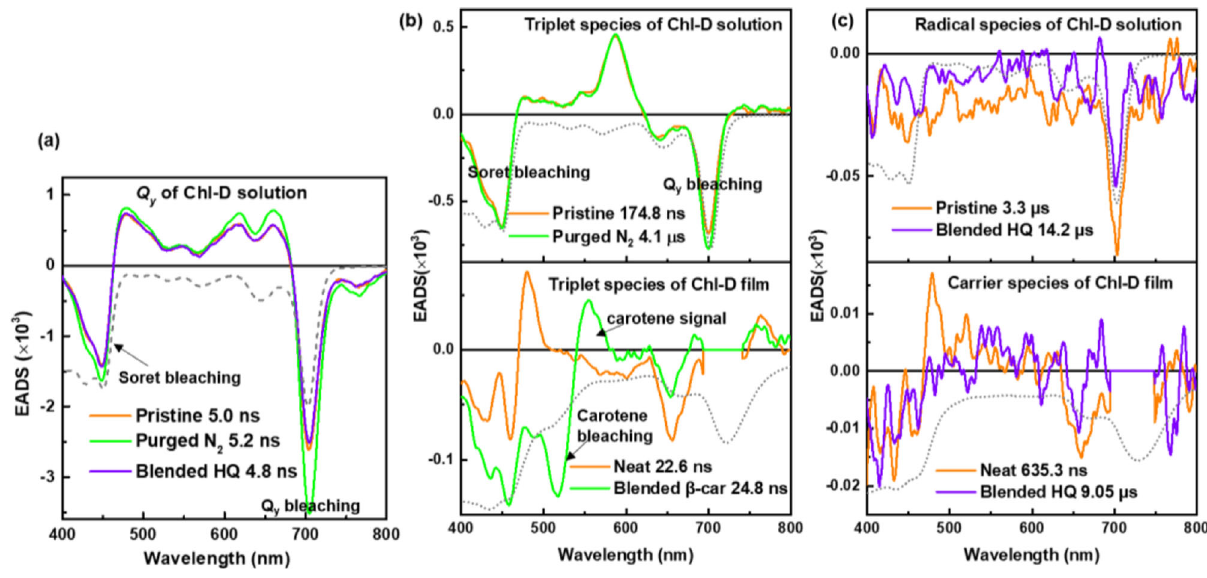
Fig. 5 The different species of EADS comparison of the Chl-D solution and fi lm. a EADS of singlet species comparison of the pristine Chl-D solution and the ones purged with N 2 gas or blended with HQ. b EADS of triplet species comparison of the Chl-D solution (the pristine and N 2 purged ones) and Chl-D fi lm (the neat and β -carotene-blended ones), and ( c ) EADS of the radical species comparison of the Chl-D solution (the pristine one and the HQ-blended one) and carrier species of Chl-D fi lm (the fi lm with and without blending with HQ). The gray broken-dotted line in each fi gure is the inverted steady-state absorption spectrum of each sample for comparison.